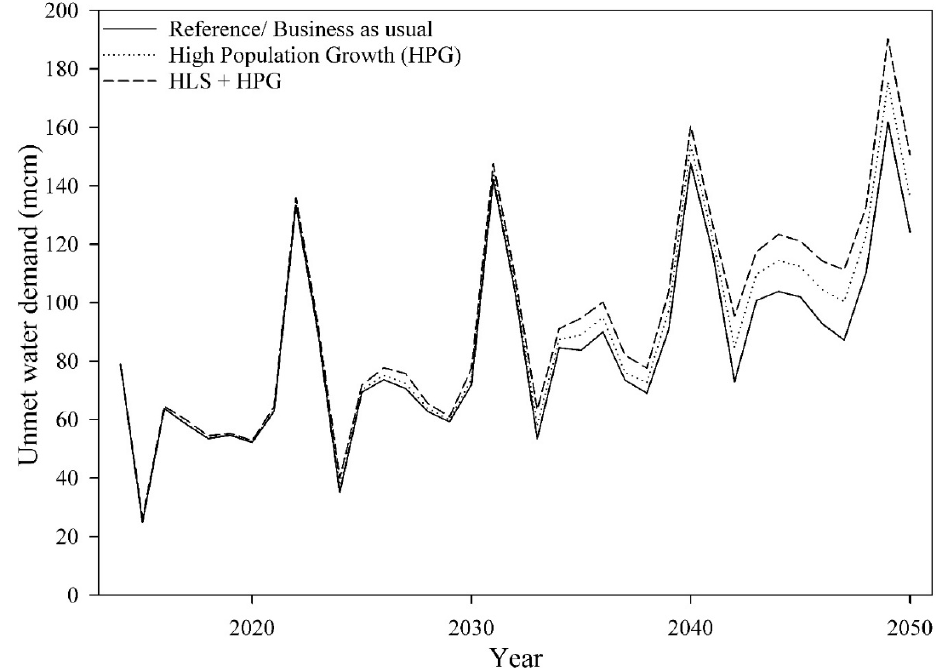
Figure 11. The future projections of the unmet water demands in the Upper Indus Basin (UIB) under the reference, high population growth, and high population growth + higher living standards scenarios for the period 2014–2050.